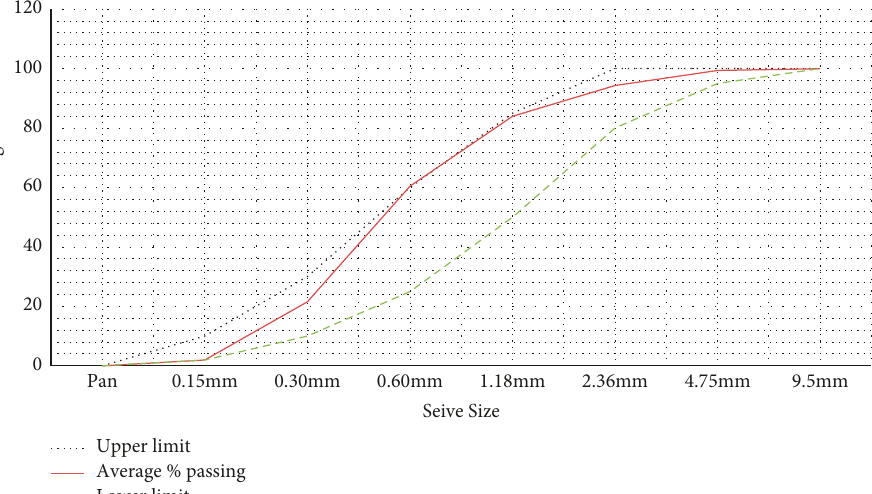
Figure 2: Fine aggregate particle size